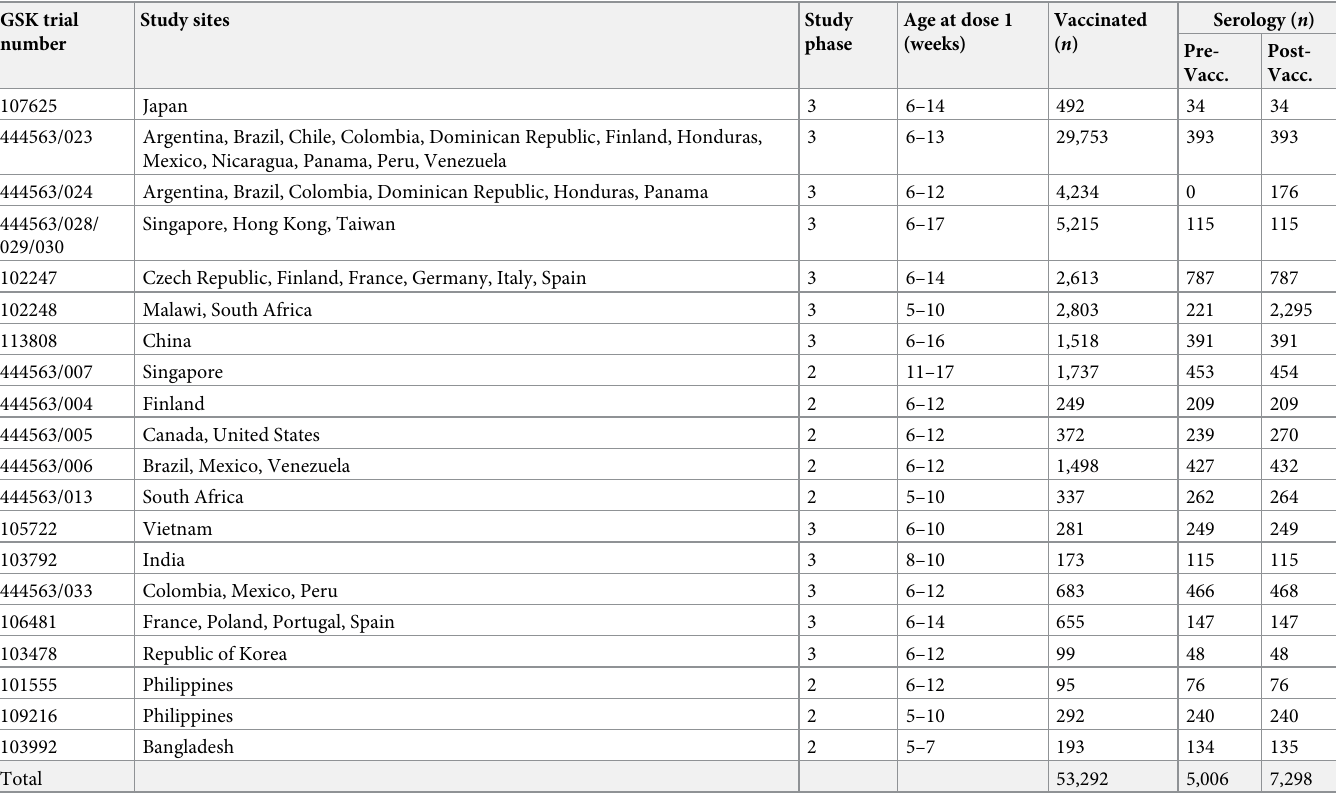
Table 1. Trial characteristics by GSK trial identification